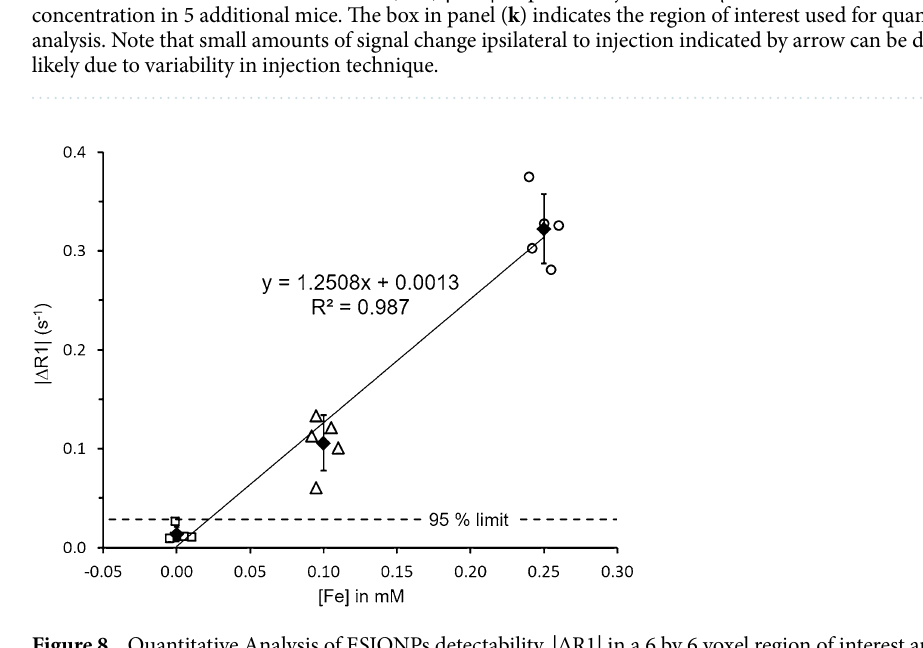
Figure 8. Quantitative Analysis of ESIONPs detectability. |ΔR1| in a 6 by 6 voxel region of interest around the injection site (shown in Fig. 7k) plotted as a function of injected iron concentration. Dashed line shows the 95% confidence interval around the |ΔR1| for saline injection (0.0 mM [Fe]), and indicates the theoretical detection limit. Solid line indicates the linear regression between |ΔR1| and [Fe]. Linear regression intersects the theoretical detection limit at about 0.03 mM